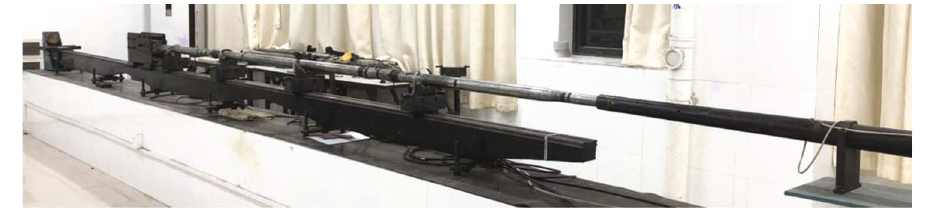
Figure 3: SHPB test device with variable cross section of 74mm diameter.